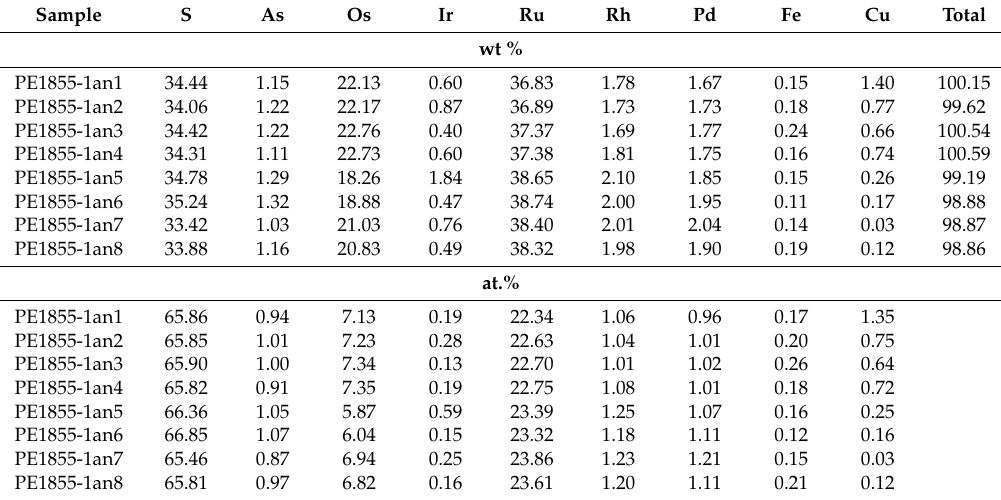
Table A4. Representative electron microprobe analyses (wt % and at.%) of laurite from chromitites of Alapaevsk. Sample